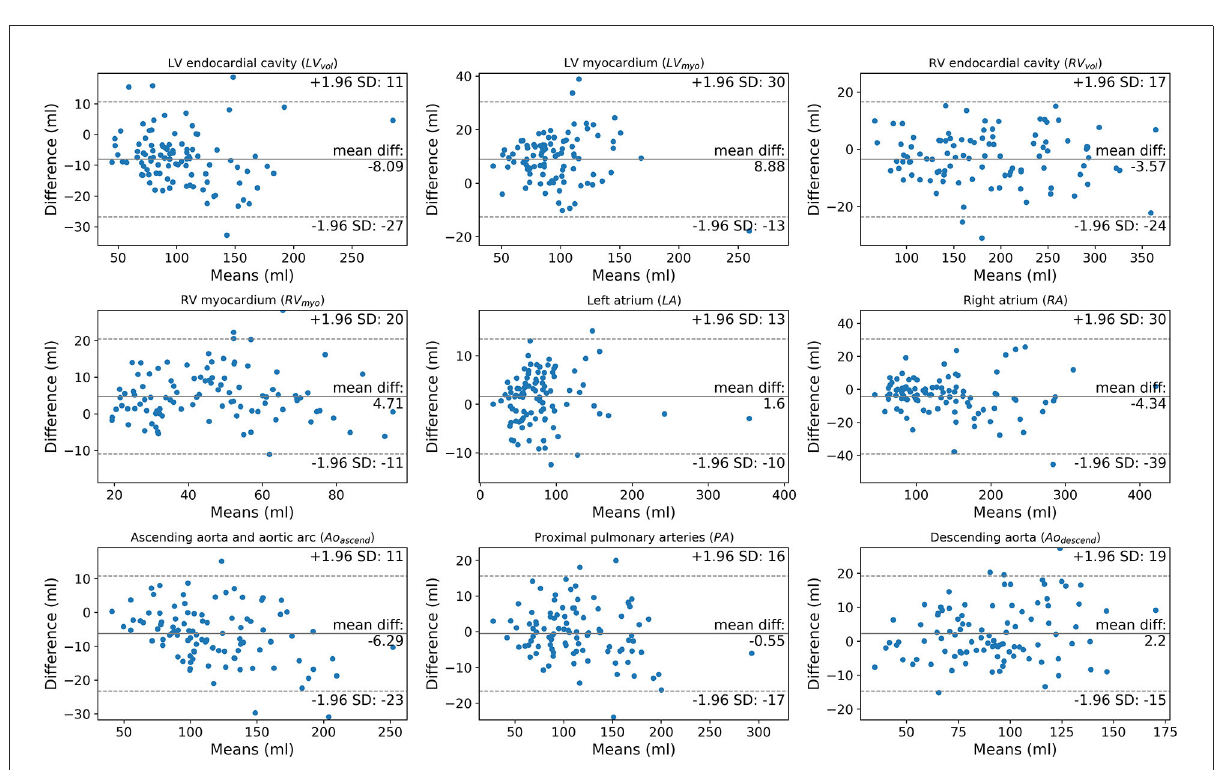
FIGURE6 Bland-Altman plots comparing manually segmented structure volumes by observer 1 (AJS) against DL model 2 in the test cohort ( n = 100).